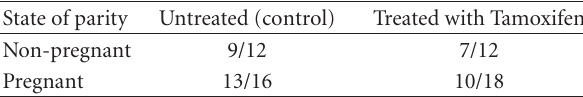
Table 2: Number of positive outgrowths from mammary glands divested of epithelium and inoculated with fragments from